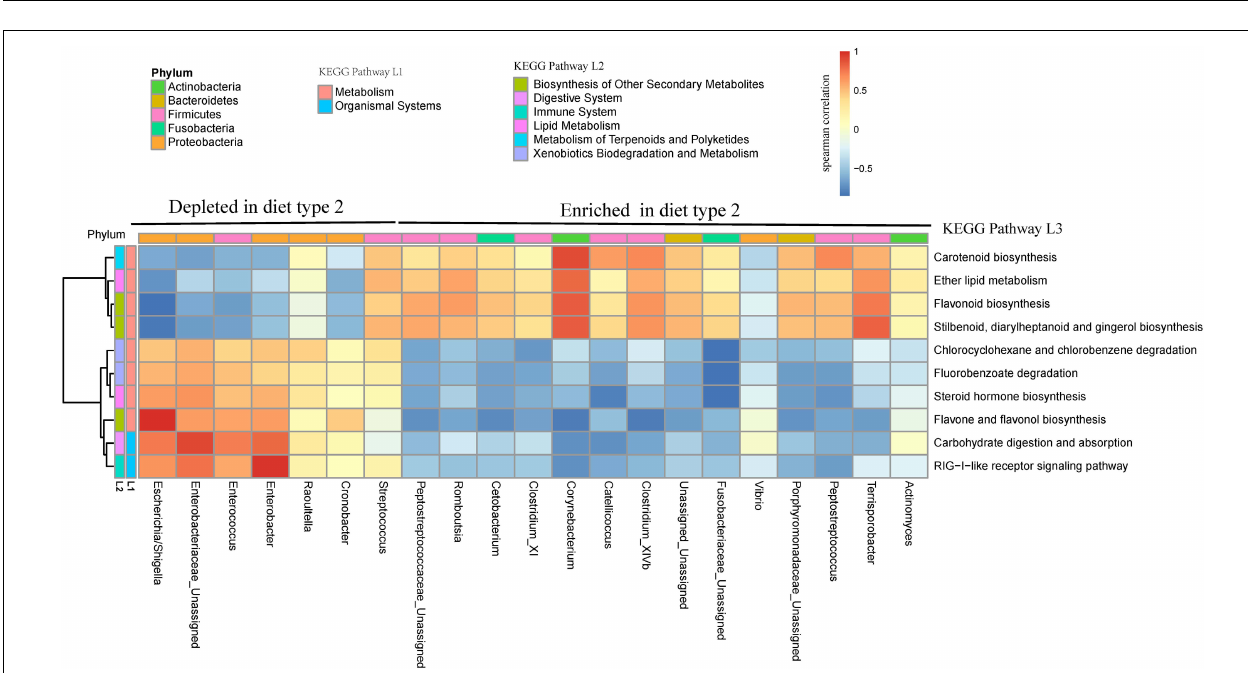
FIGURE 6 | Diet-induced changes in gut microbiota during Crested ibis’ growth. (A) Enriched and depleted ASVs for comparison between diet type 2 and diet type 1. (B) The relative abundance of enriched and depleted bacteria genus for different diet types along with the age. The shown ASVs and genus was obtained from the differential abundance analysis which was conducted by fitting a generalized linear mixed model with a negative binomial distribution in edgeR. Genus counts were normalized for edgeR size factor.